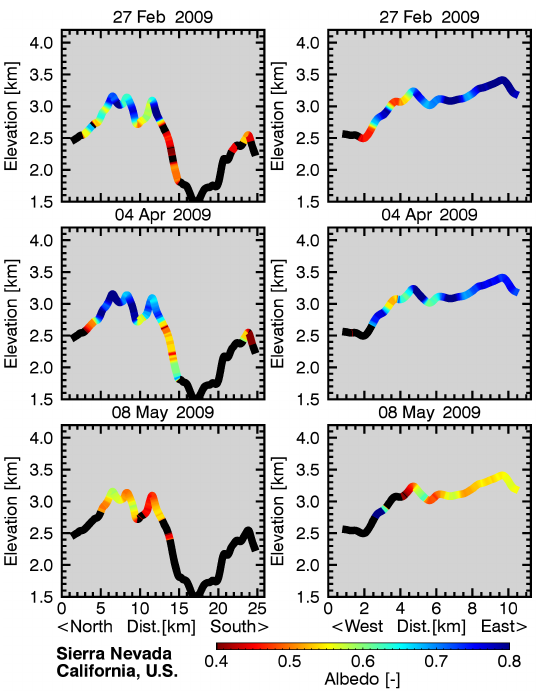
Figure 10. Snow albedo along a north–south (left panels) and west– east transect (right panels) through the middle of the observed Sierra Nevada area. The values are smoothed with a boxcar average of 30 pixels. The snow-free surface is shown in black.